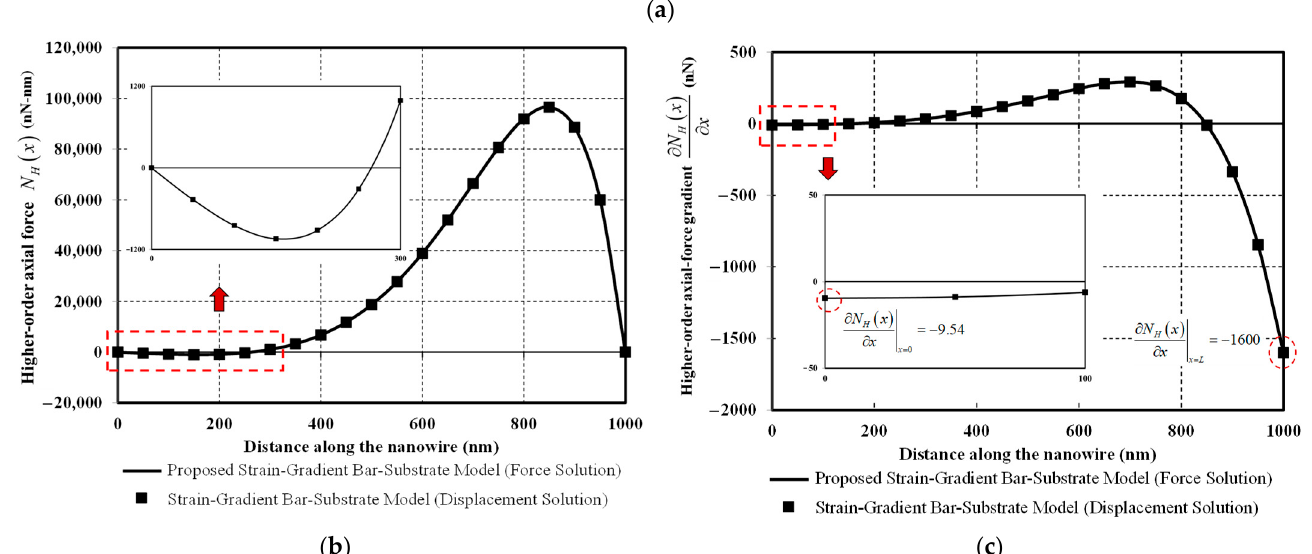
( ) N x ; ( c ) Higher-order axial-force gradient ( x ) ; ( c ) Higher-order axial-force gradient ∂ N H H